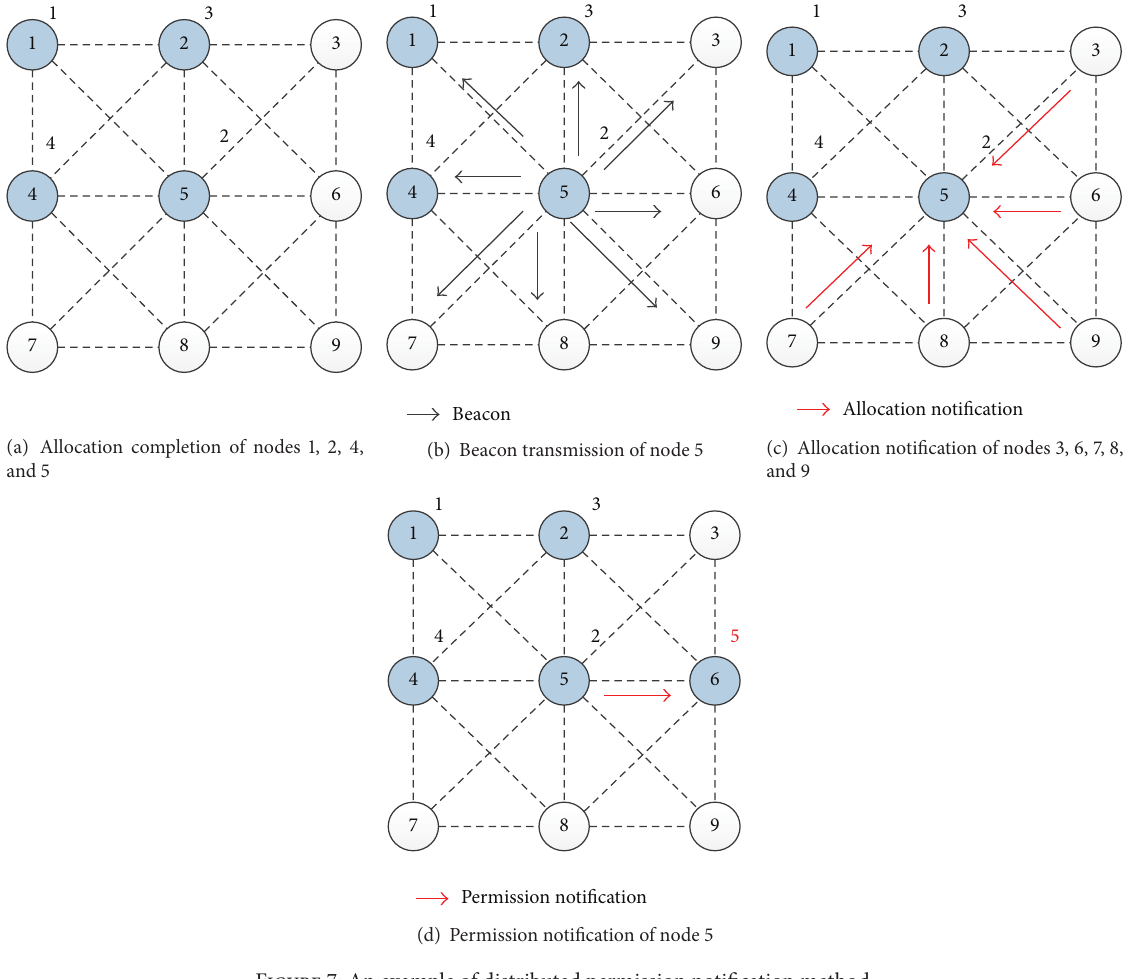
Figure 7: An example of distributed permission notification